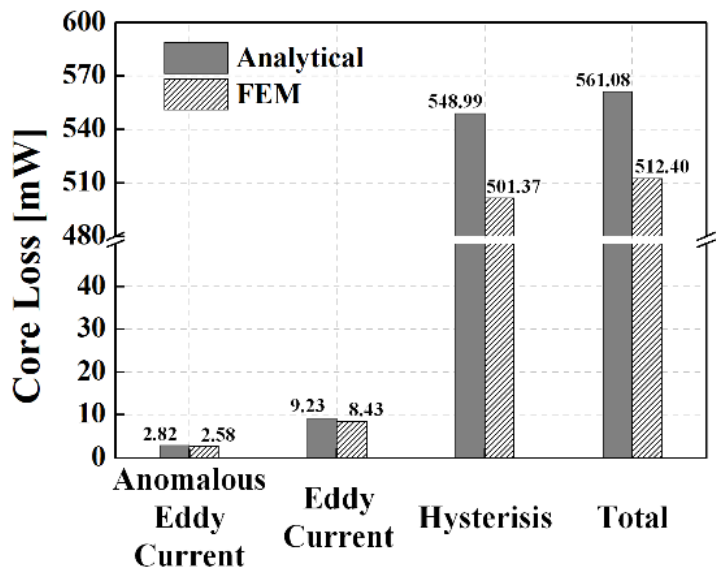
Figure 7. Modified Steinmetz equation and FEM core-loss comparison results.